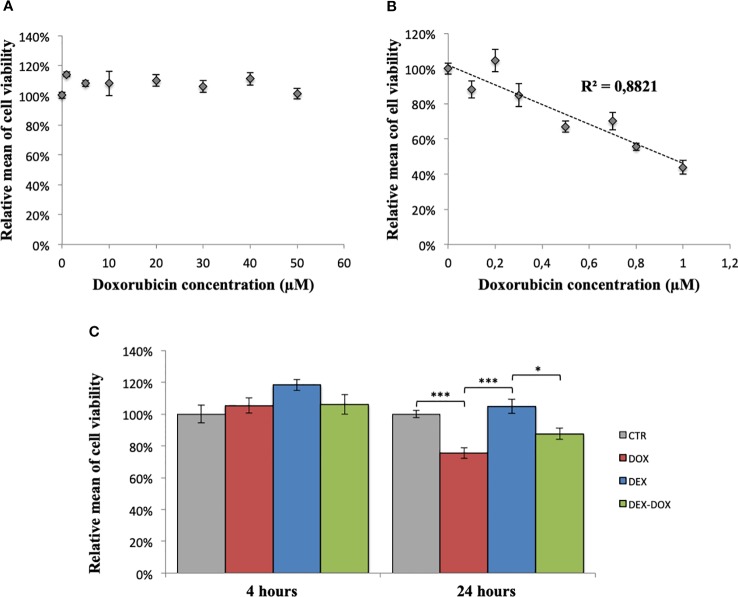
Relative mean of H9C2 cells viability measured by violet crystal assay. (A) After 4 hours of exposure to different doses of DOX. (B) After 24 hours of exposure to different doses of DOX. (C) Effect of DEX alone treatment and 30 minutes pre-incubation on both 4 and 24 hours of DOX exposure. One-way ANOVA with multiple comparisons: *p value < 0.05, ***p value < 0.001.